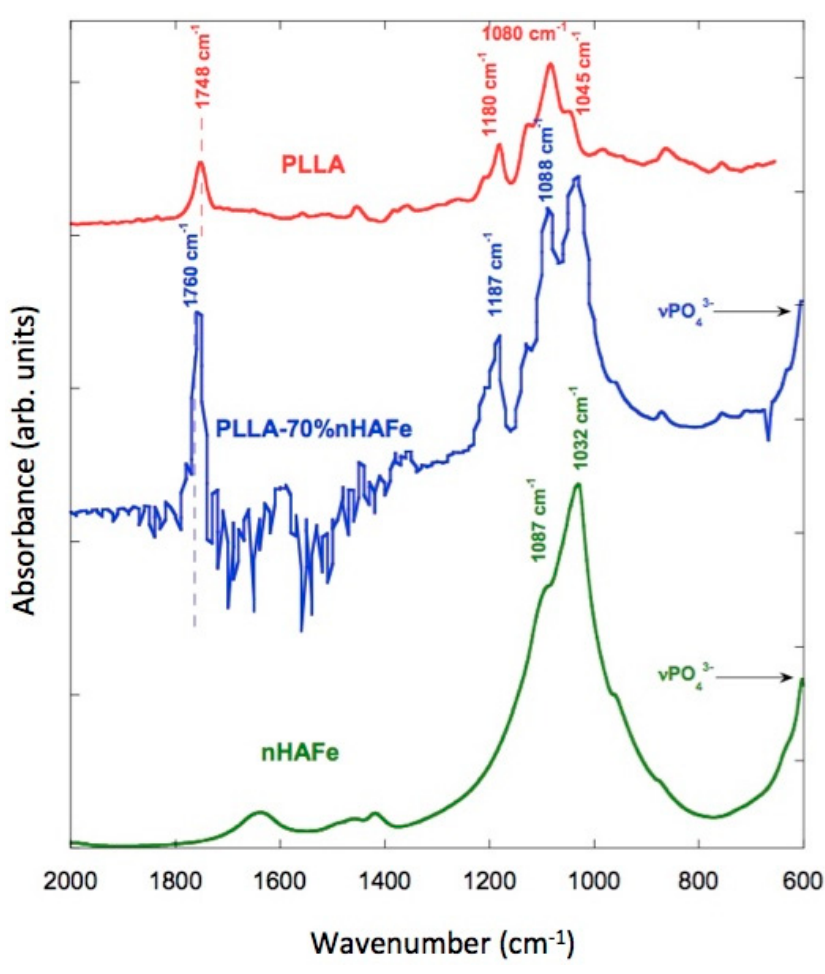
Figure 8. Fourier-transform infrared spectroscopy (FTIR) spectra of FeHA, PLLA/FeHA 70 wt % and pure PLLA.